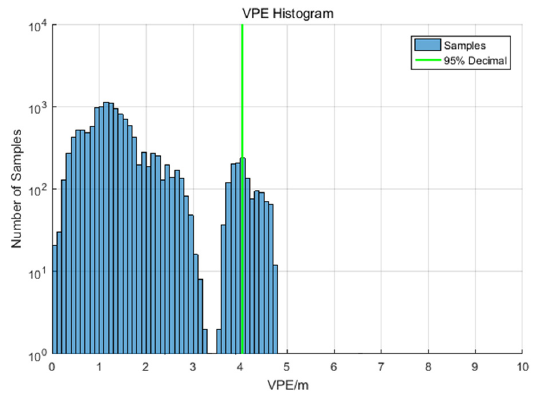
Figure 21. The VPE histogram of flight test-III. The green line in the figure is the vertical accuracy (95%), which is 4.04 m.